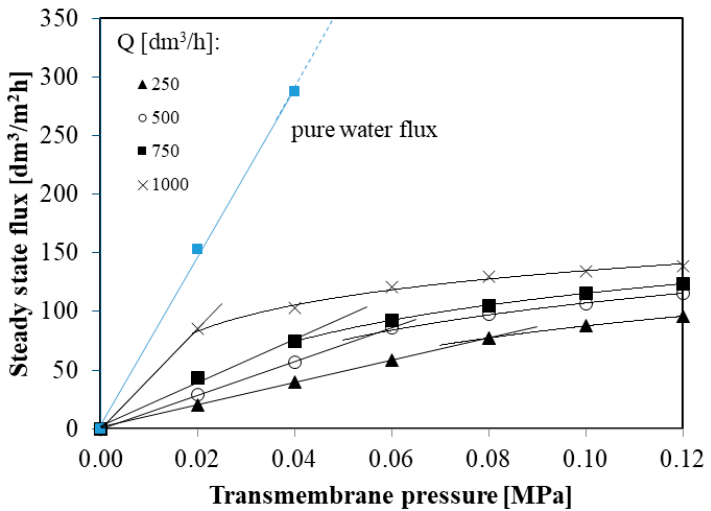
Figure 5. The steady state permeate flux in function of transmembrane pressure at different feed flow rates.